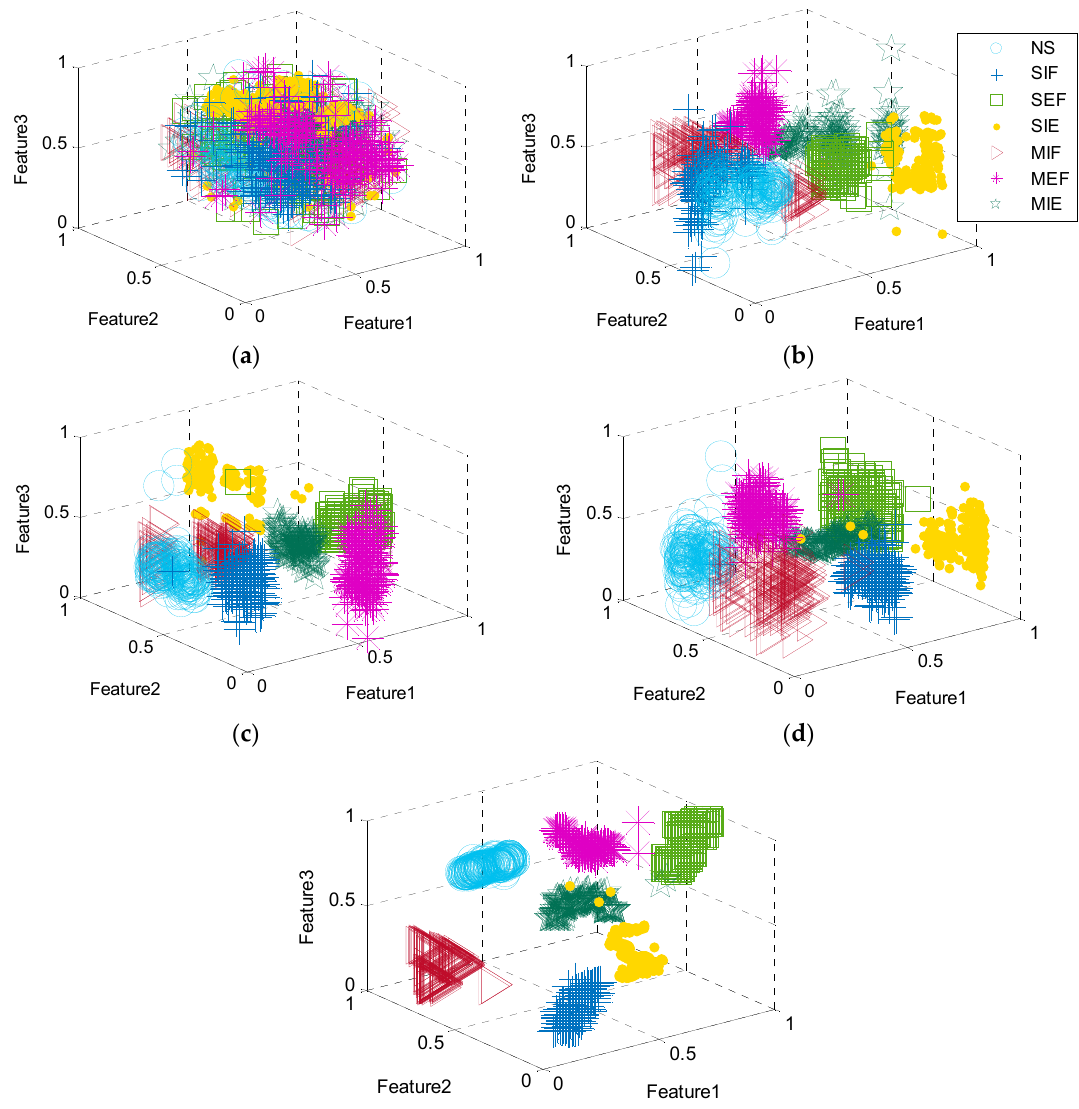
Figure 10. Features of each layer extracted by T-Distribution Stochastic Neighbor Embedding (t-SNE): ( a ) the input layer, ( b ) the second layer, ( c ) the third layer, ( d ) the latent feature space z , and ( e ) the last hidden layer.